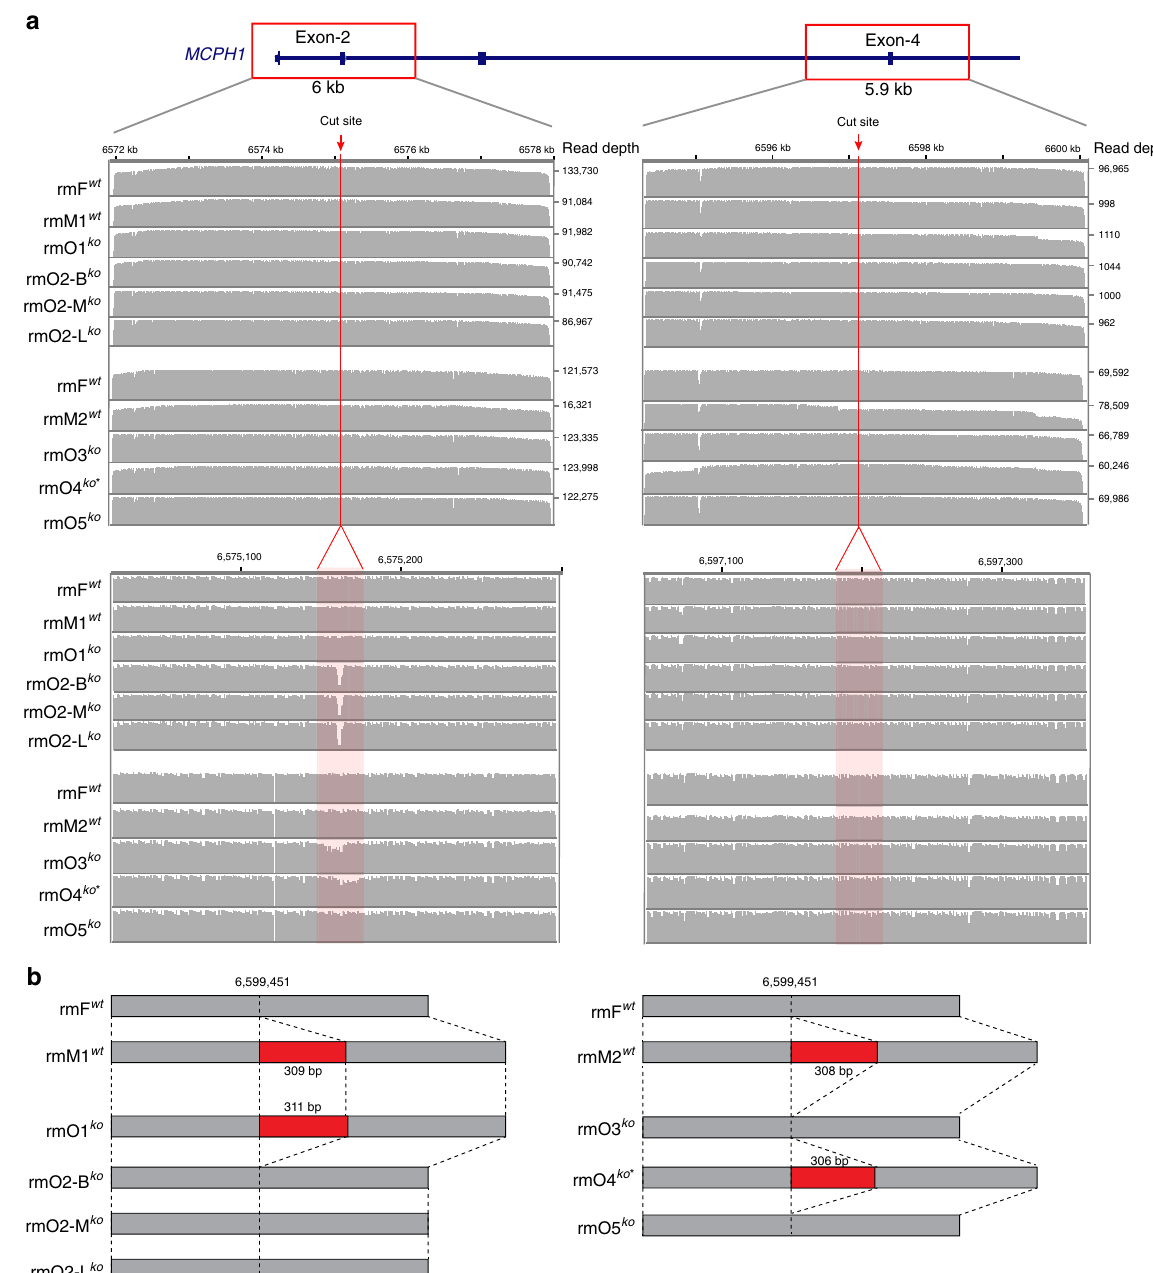
Fig. 2 Long-read sequencing analysis of the sgRNA targeted regions. a The two sgRNA target regions of MCPH1 (exon2 and exon4, respectively) tested by long-range PCR and PacBio sequencing. The upper and bottom panels show the coverage of the PacBio reads on the target regions based on whole-region view and cut-site region view, respectively. The cut sites of the sgRNAs in exon2 and exon4 are indicated with red arrow, red line, and shadow frame in red. b A ~300 bp insertion at the near-target region (2.3 kb from the cut-site) in two Cas9-edited monkeys (rmO1 ko and rmO4 ko* ), which inherited from their wildtype mother (rmM1 wt and rmM2 wt